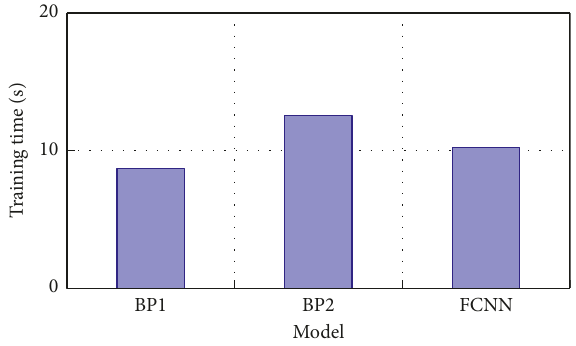
Figure 11: Training time of different recognition models.